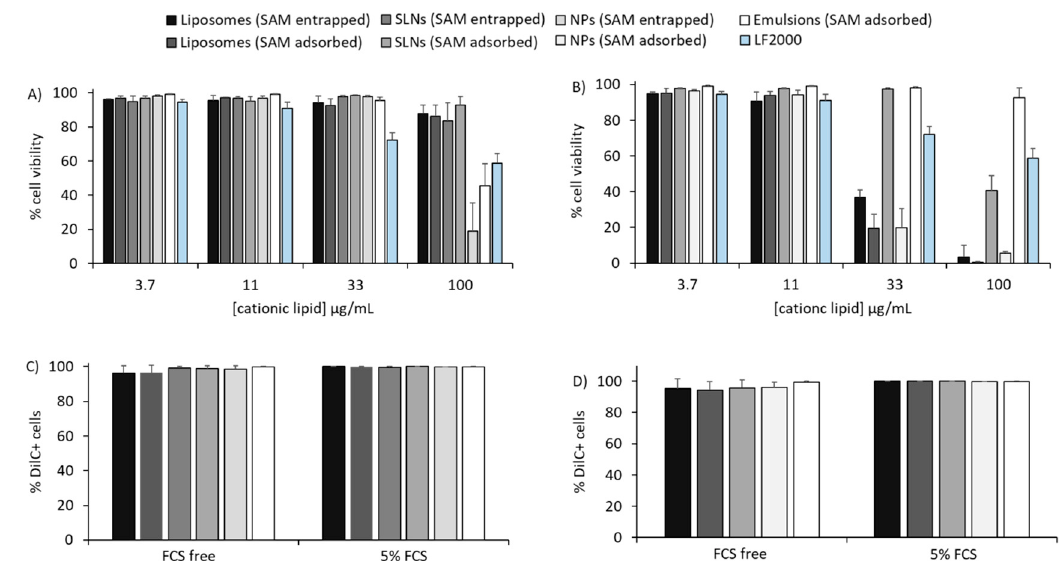
Figure 1. Cell viability and cell association of delivery platforms with baby hamster kidney (BHK) cells. Cytotoxicity ( A , B ) and cell association ( C , D ) in BHK cell of DOTAP-based ( A , C ) and DDA-based ( B , D ) liposomes, SLNs, NPs and emulsions. Lipofectamine 2000 (LF2000) was used as positive control. For cell viability, cationic lipid concentrations of 3.7 to 100 µ g / mL (N:P ratio of 8:1) were tested. For cell association, the results represent percentage of 1,1’-dioctadecyl-3,3,3’,3’-tetramethylindocarbocyanine perchlorate (DilC)-positive BHK cells after 16 hours of incubation with 11 µ g / mL of DOTAP-based (C) and DDA (D) formulations in either 5% fetal calf serum (FCS) or FCS-free media. Results are represented as mean ± SD of 3 independent experiments.